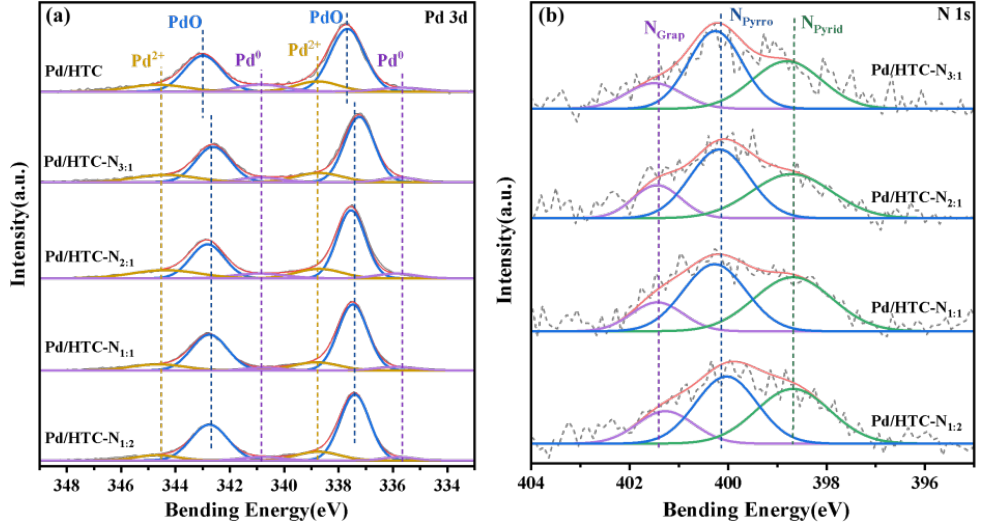
Figure 8. High resolution of Pd 3d ( a ) and N 1S ( b ) XPS spectra of the catalysts.